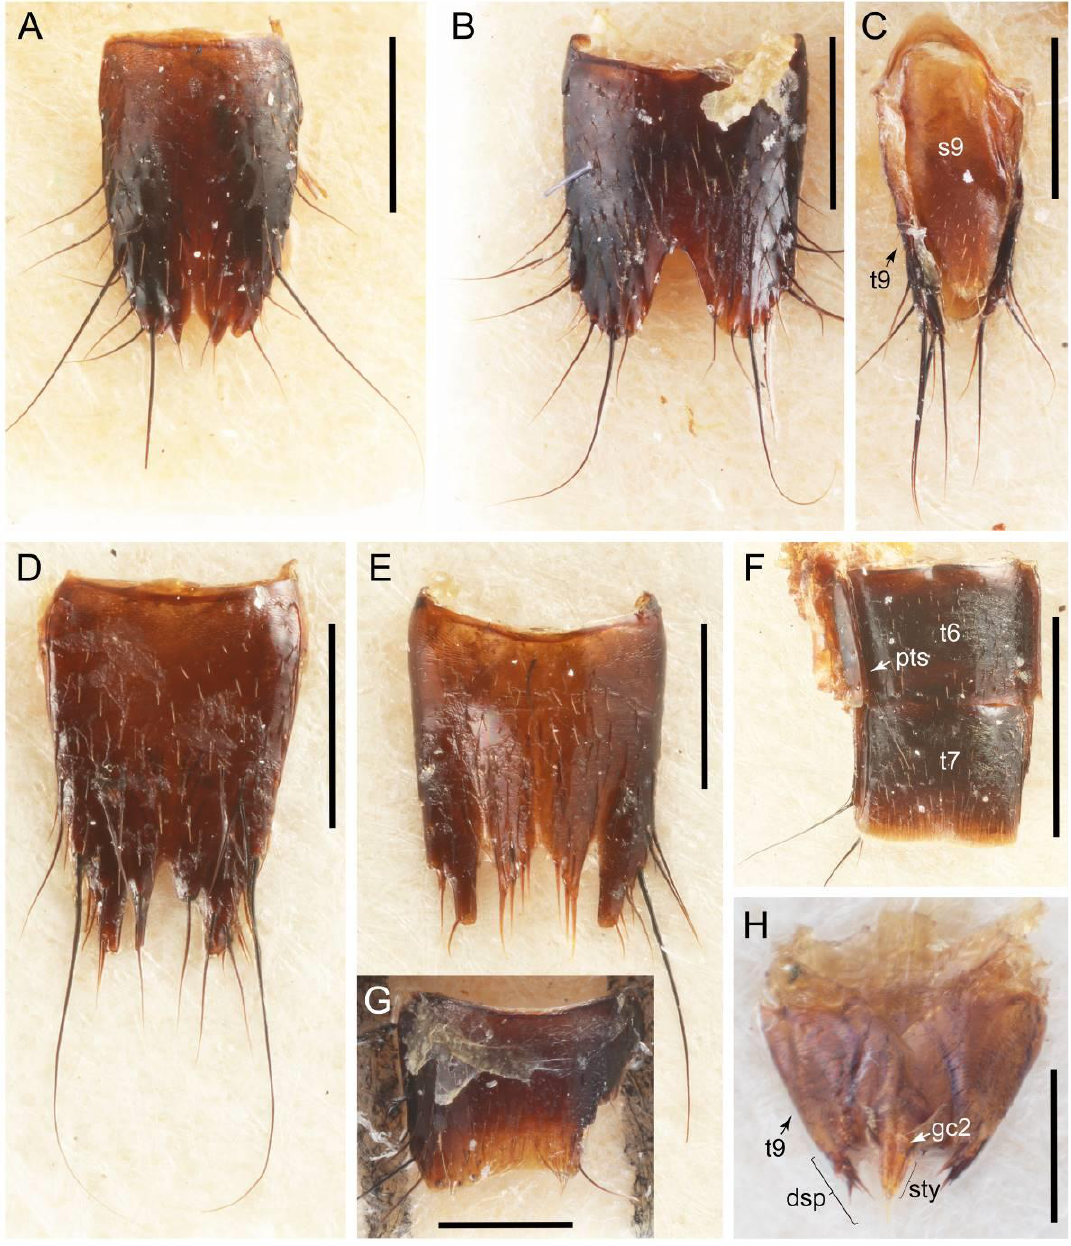
Figure 39. Photographs of Vatesini ( Tachinoporus basalis ). ( A ) male tergite VIII, dorsal view. ( B ) male sternite VIII, ventral view. ( C ) male tergite IX and sternite IX, ventral view. ( D ) female tergite VIII of the syntype, dorsal view. ( E ) female sternite VIII of the syntype, ventral view. ( F ) female tergites VI–VII and their associated paratergites of the syntype, dorsal view. ( G ) male sternite VII, ventral view. ( H ) female genital segments of the syntype, dorsal view. Scale bars: 0.5 mm ( A – E , G ); 1.0 mm ( F ); 0.3 mm ( H ). Abbreviations: dsp, developed short spines; gc2, gonocoxite II; pts, paratergites; s9, sternite IX; sty, gonostylus; t6–7, 9, tergite VI–VII,